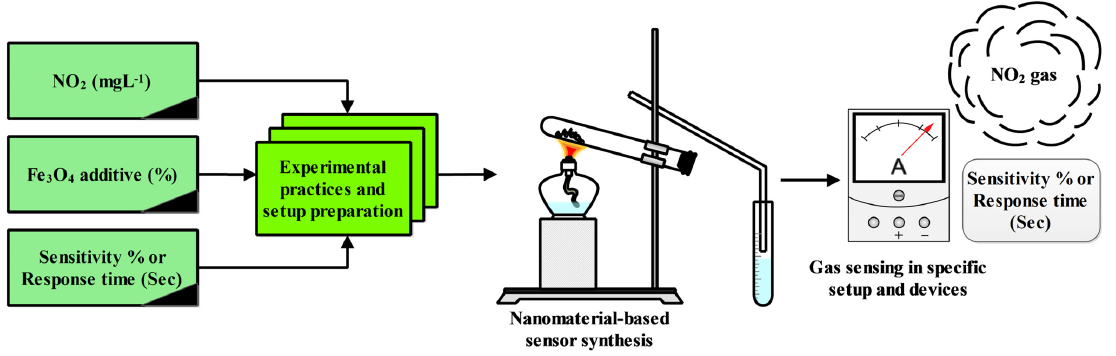
Figure 1. The effect of three factors on each other in the performance of a NO 2 gas sensor.